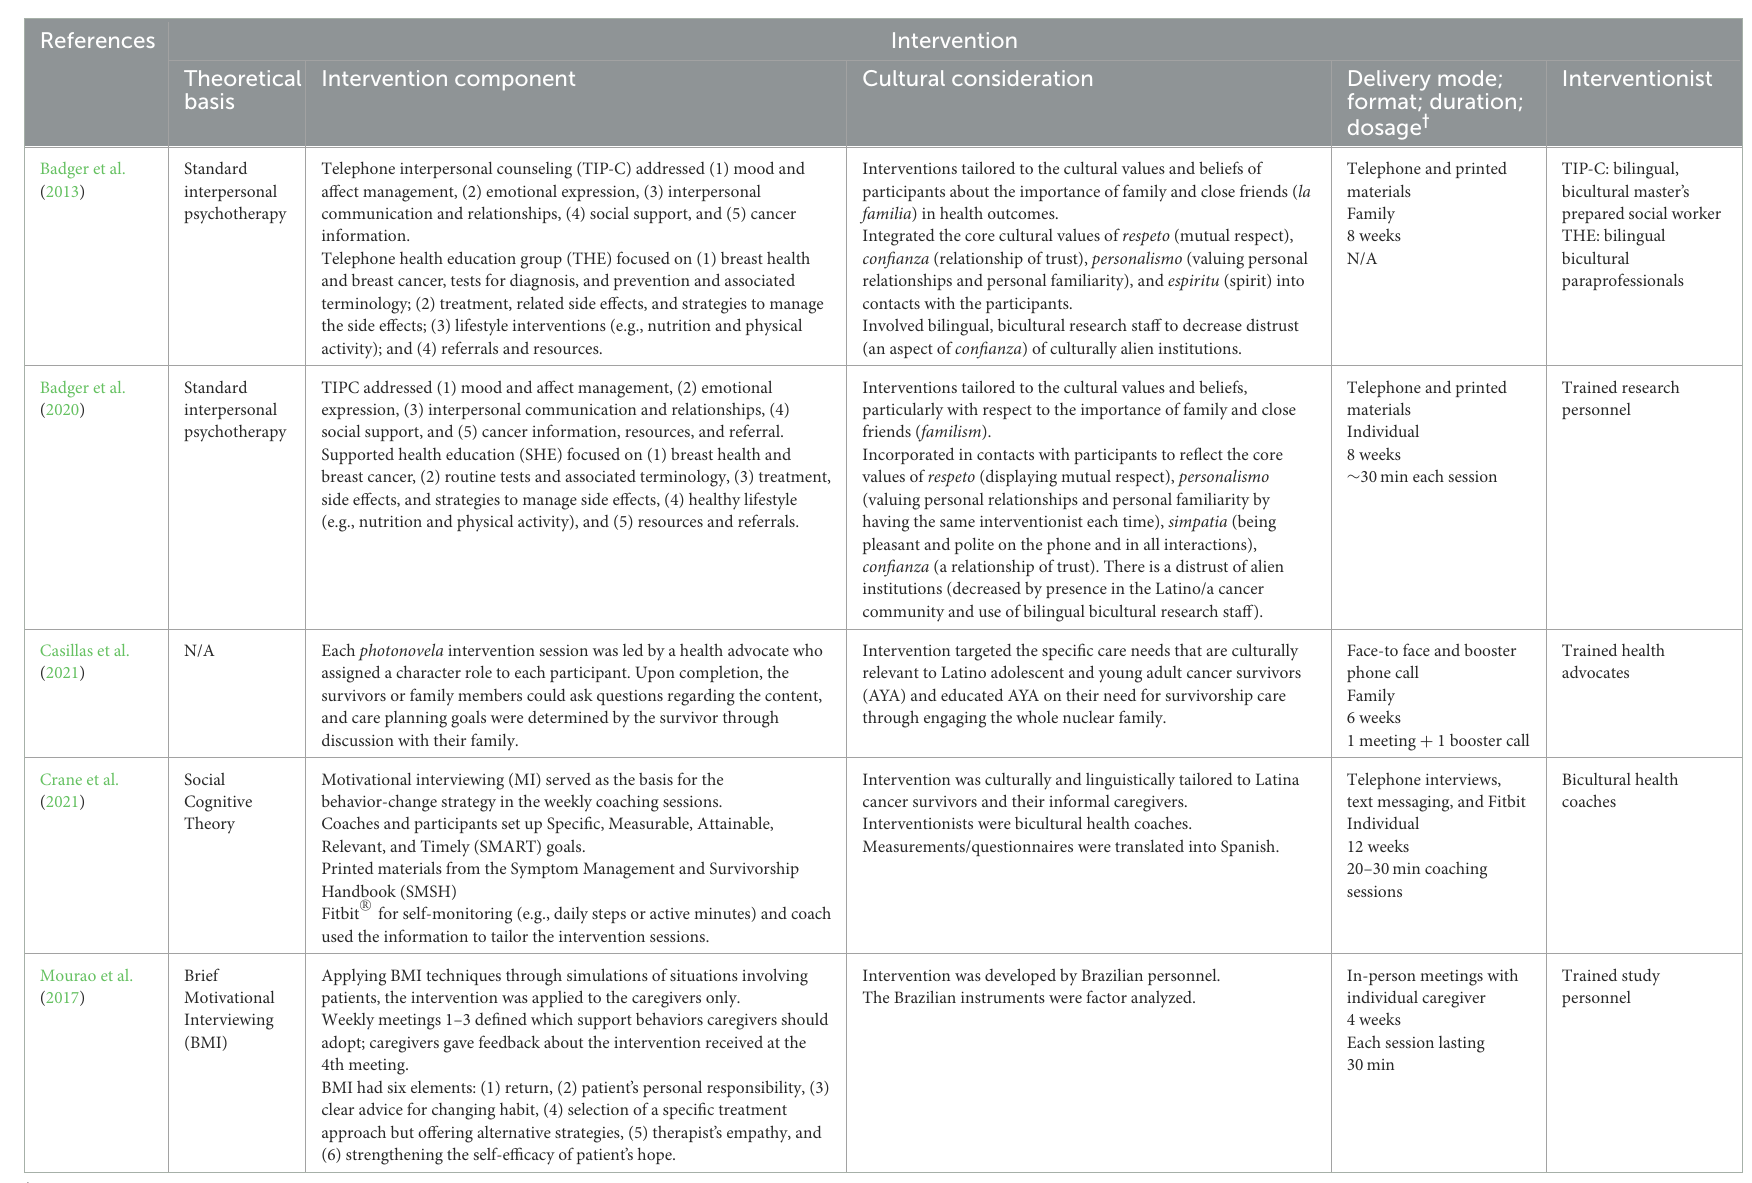
TABLE 3 Intervention